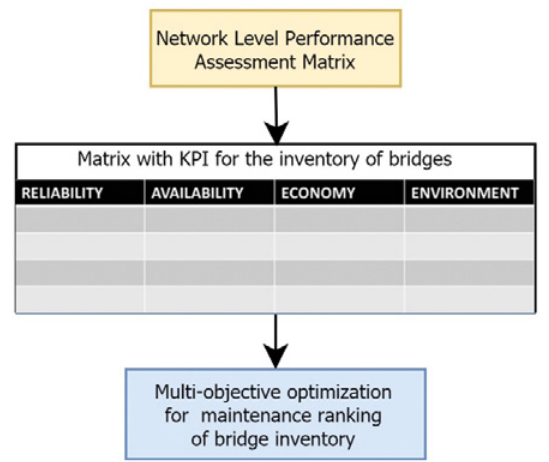
Figure 1. Overview of the process for performance goals